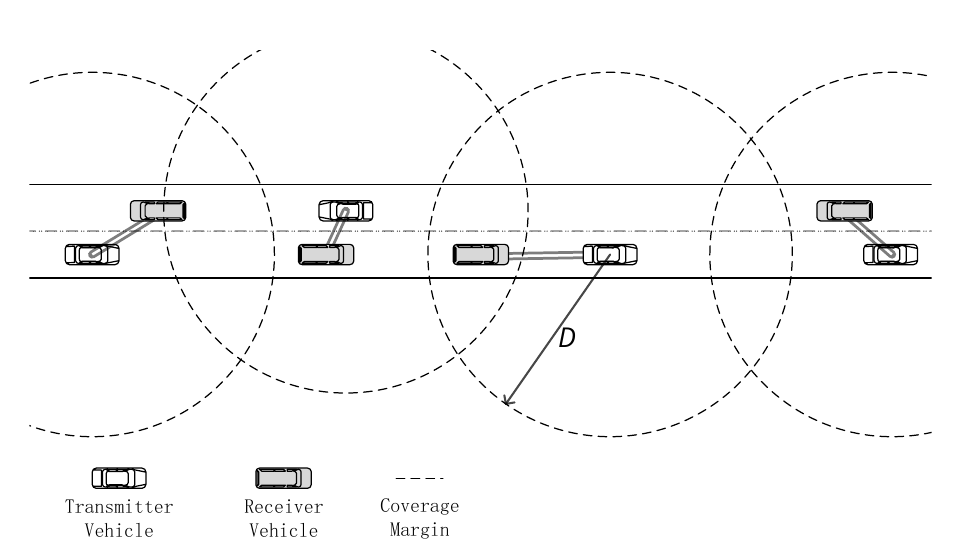
Figure 1. Basic illustration of theoretical model.